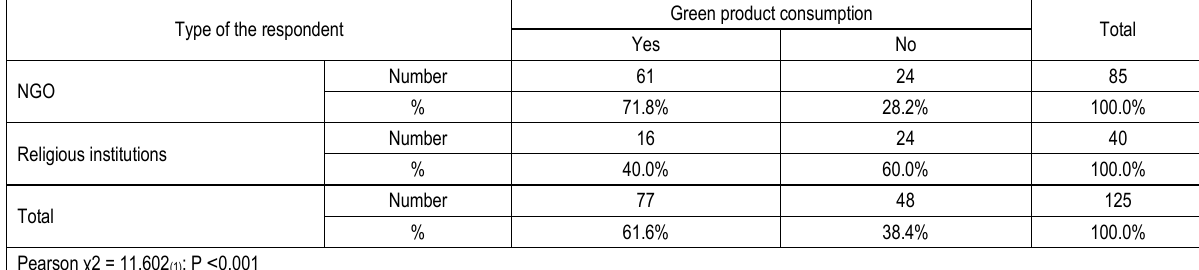
Table 5. Relationship between different types of institutes and green product consumption